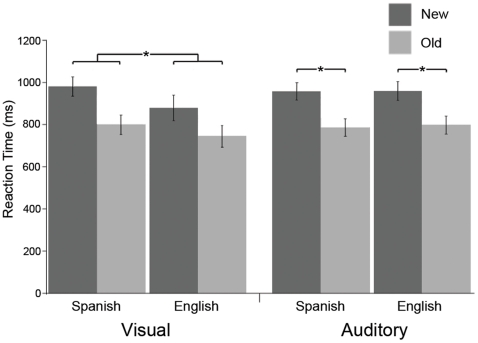
Mean reaction times for 16 subjects.Subjects responded faster to old words in both languages and modalities, and responded faster to English words in the visual modality. Error bars represent the standard error of the mean.